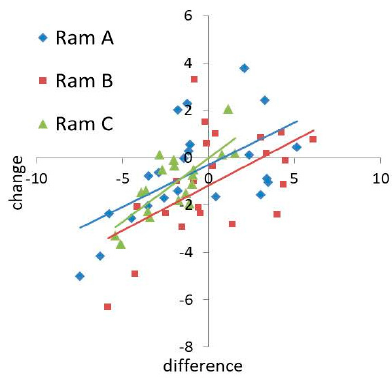
Figure 3. Ejaculate level e ff ects of seminal plasma supplementation on changes in sperm hyperactivity